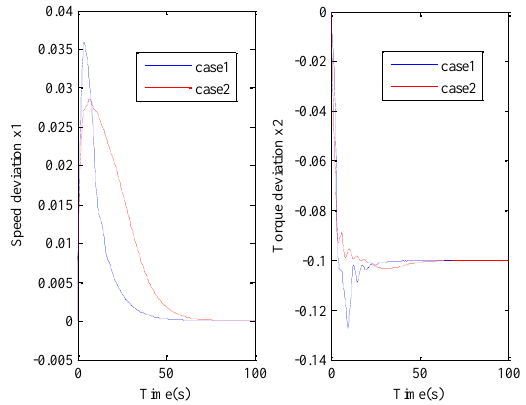
Figure 6(a). Speed deviation x1 and torque deviation x2.